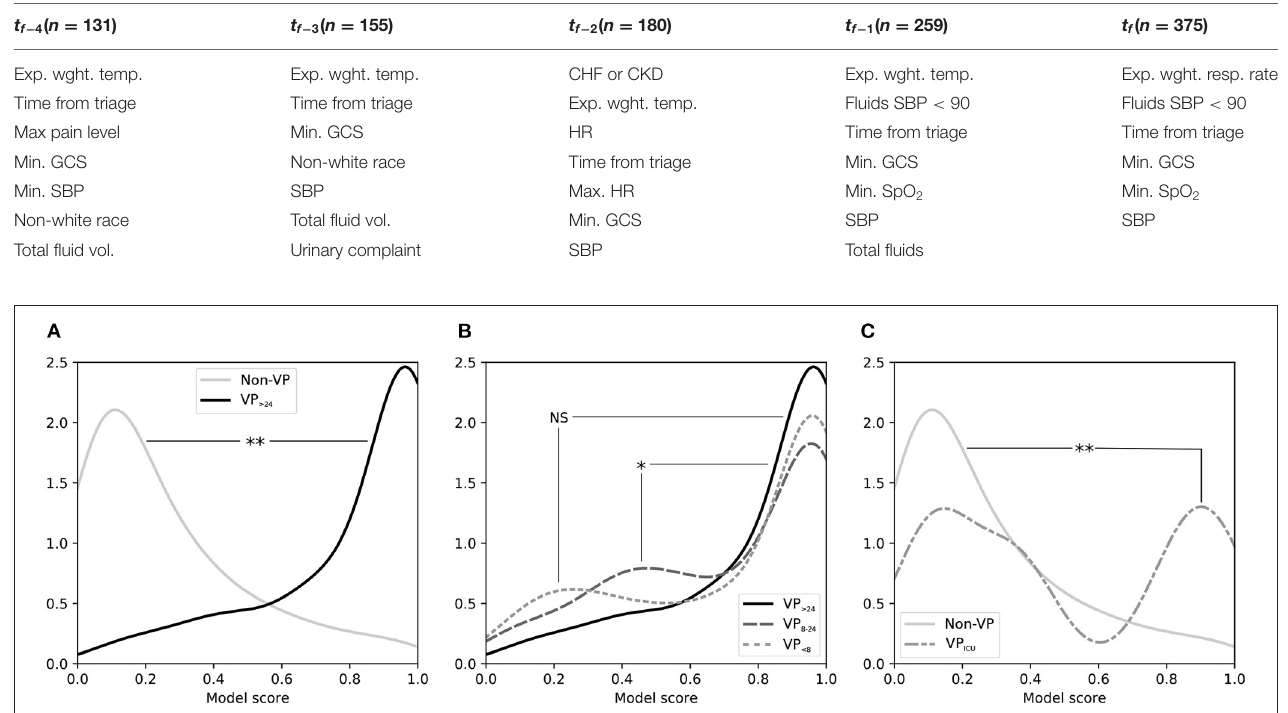
FIGURE 4 | Smoothed distribution of scores for t f from an LR model trained to discriminate between ED patients with sepsis requiring vasopressors and patients not requiring vasopressors. (A) Comparing distributions for Non-VP patients (those not given vasopressors in the first 48 h of the hospital visit) vs. VP > 24 patients (those receiving vasopressors beginning in the ED and continuing for > 24 h) shows that the model separates these two groups well. (B) Comparing distributions for VP > 24 patients vs. VP < 8 patients (those receiving vasopressors beginning in the ED but for < 8 h) shows that patients who were weaned from ED vasopressors quickly appeared similar to patients who needed vasopressors for a lengthy duration, though VP 8 - 24 patients (those with an intermediate vasopressor duration of 8–24 h) showed a minor but statistically significant difference. (C) Comparing distributions for Non-VP patients (those not requiring vasopressors) vs. VP ICU patients (those who received vasopressors initiated in the ICU after leaving the ED) shows that the latter had a bimodal distribution when in the ED, which was significantly higher than the Non-VP group. ED, emergency department; t f : “final ED decision